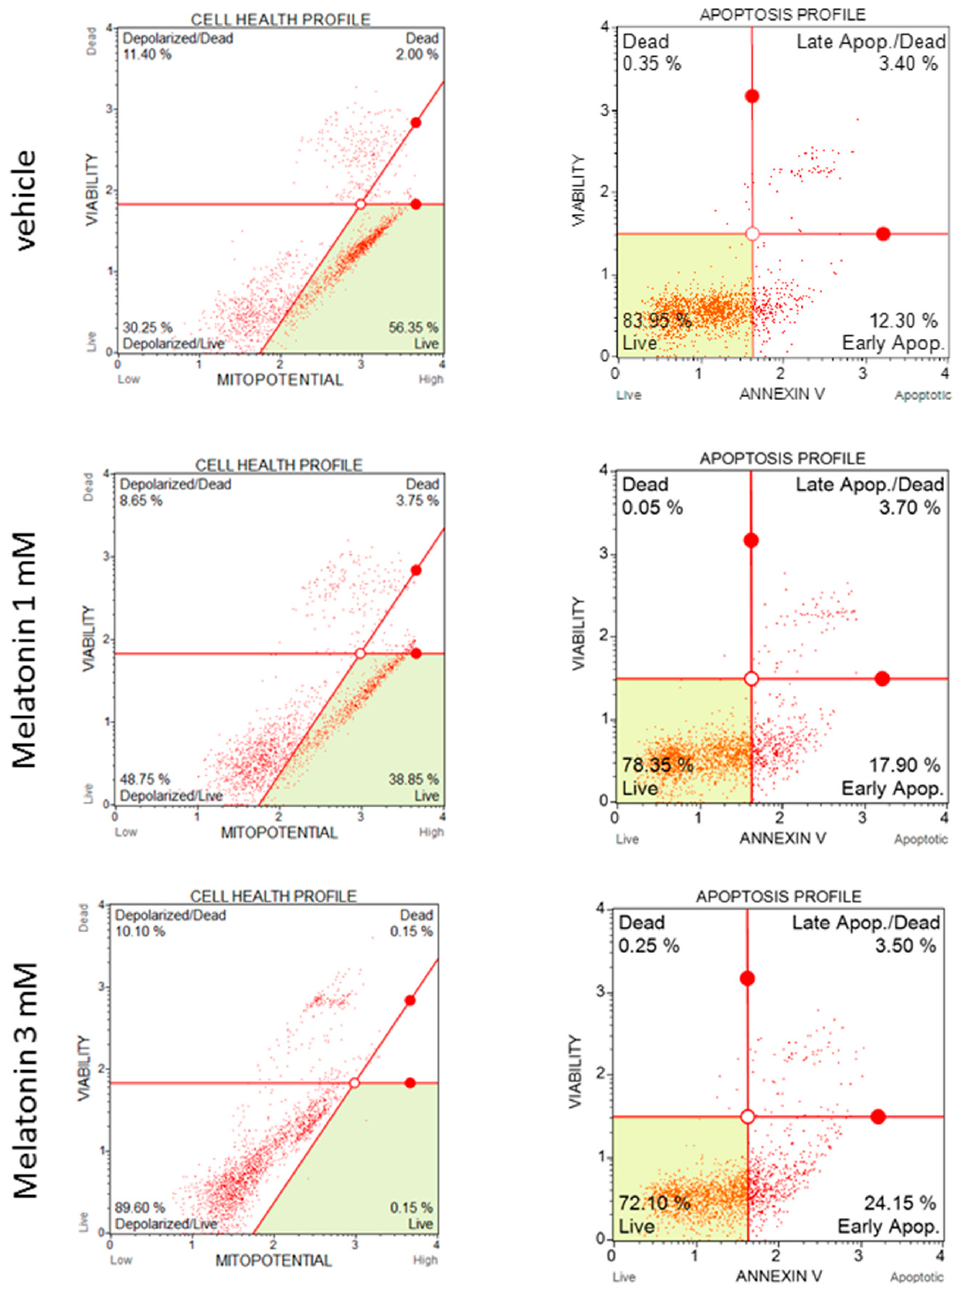
Figure 5. Melatonin induces mitochondrial membrane depolarization and apoptosis—U87MG cells were incubated with melatonin (1 mM or 3 mM) for 72 h, and the medium was exchanged every 24 h. ( A ) Mitochondrial polarization was evaluated by cytometry using a Muse ® Mitopotential Assay Kit. The depolarized group was represented by the sum of depolarized live and dead cells. Membrane polarization did not differ in cells treated with vehicle or 0.3% and 0.9% ethanol, and these groups were represented as a single bar. ( B ) Apoptosis was evaluated by cytometry using the Muse ® Annexin V & Dead Cell Assay Kit. The necrotic group represents the sum of dead cells and late apoptotic/dead cells presented in the representative plots. * p > 0.05 compared to vehicle. The statistical analysis consisted of an ANOVA followed by Bonferroni’s post-hoc